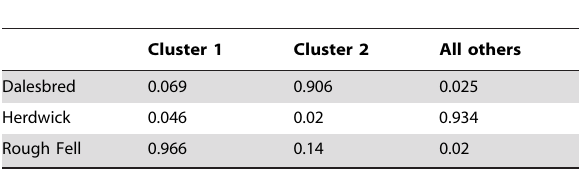
Table 5. The proportion of membership of each of the three breeds Rough Fell, Dalesbred and Herdwick in each of the three clusters inferred by Structure shown in Figure